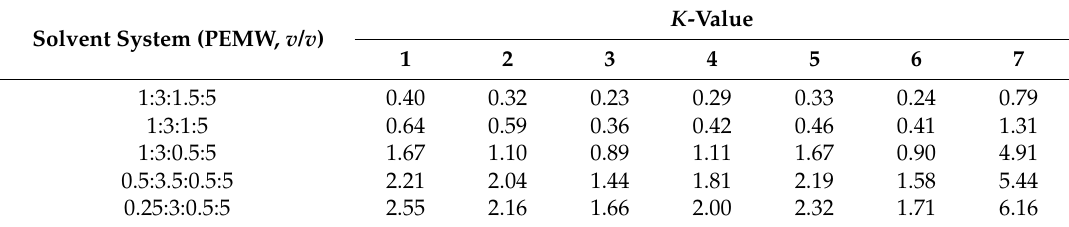
Table 1. K -values of target compounds in different two-phase solvent systems.